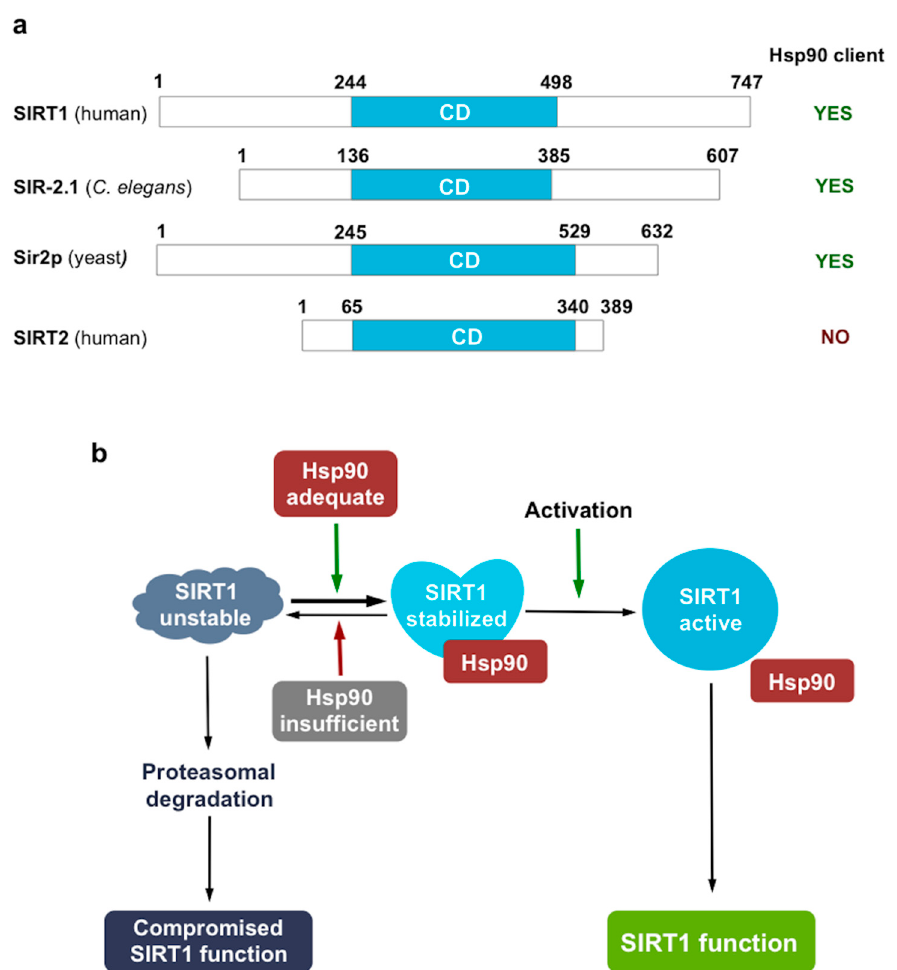
Figure 4. A conserved chaperone-client interaction between Hsp90 and SIRT1 orthologs. ( a ) SIRT1 orthologs possess extensive N- and C-terminal domains. Domain structures of yeast, worm, and human SIRT1 orthologs and the SIRT1 paralog SIRT2. Numbers denote the number of amino acid residues at the respective domain boundaries. The catalytic core domains (CD) are in light blue, N- and C-terminal regions are in white. ( b ) Hypothetical model of the conformational regulation of SIRT1 (and respective orthologs) by Hsp90. Hsp90 binds the nascent, unstable SIRT1 in the cytosol and stabilizes it in